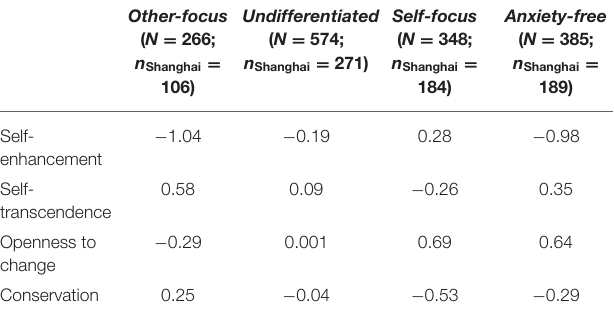
TABLE 3 | Four value clusters created by K-means